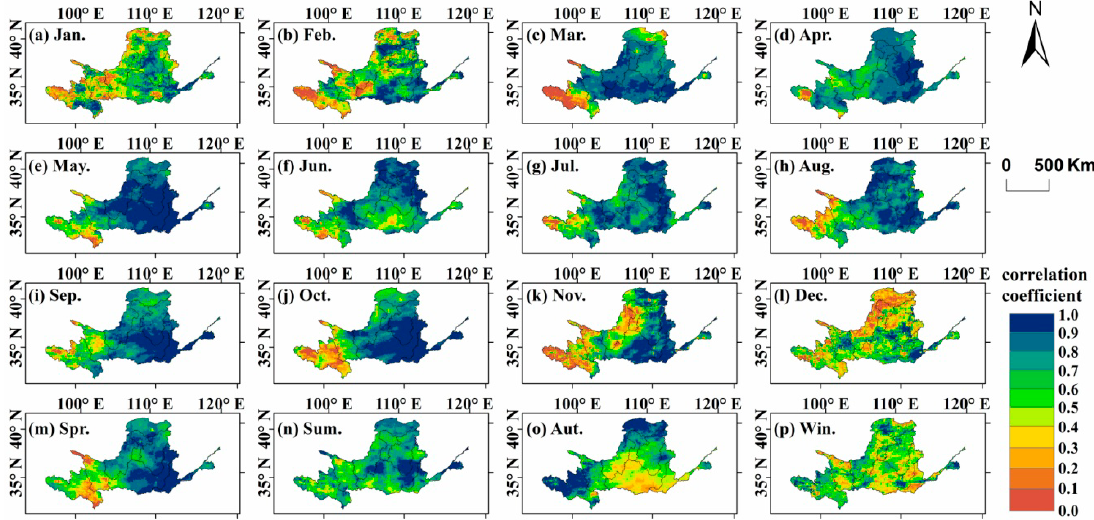
Figure 4. Distribution of correlation coefficient (CC) between Gridded Standardized Precipitation Evapotranspiration Index (GSPEI) and Standardized Precipitation Evapotranspiration Index (SPEI).